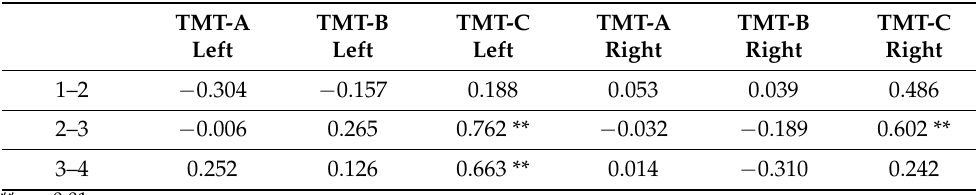
Table 3. Correlation between the difference in hemoglobin concentration change and the difference in amylase value.